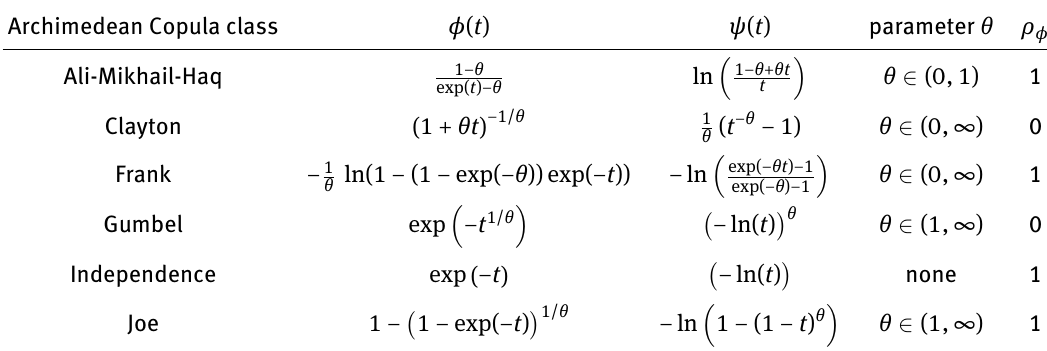
Table 1: Condition on ρ ϕ for classical generators in the case of most popular Archimedean copulas.